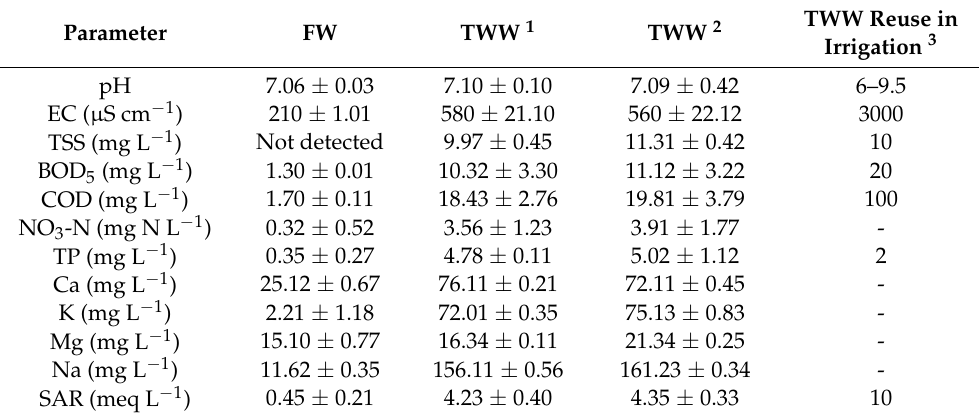
Table 4. Biological and chemical composition of freshwater (FW) and treated wastewater (TWW) which were applied for irrigation of giant reed. Average ( ± standard deviation) values of five-year- tests are